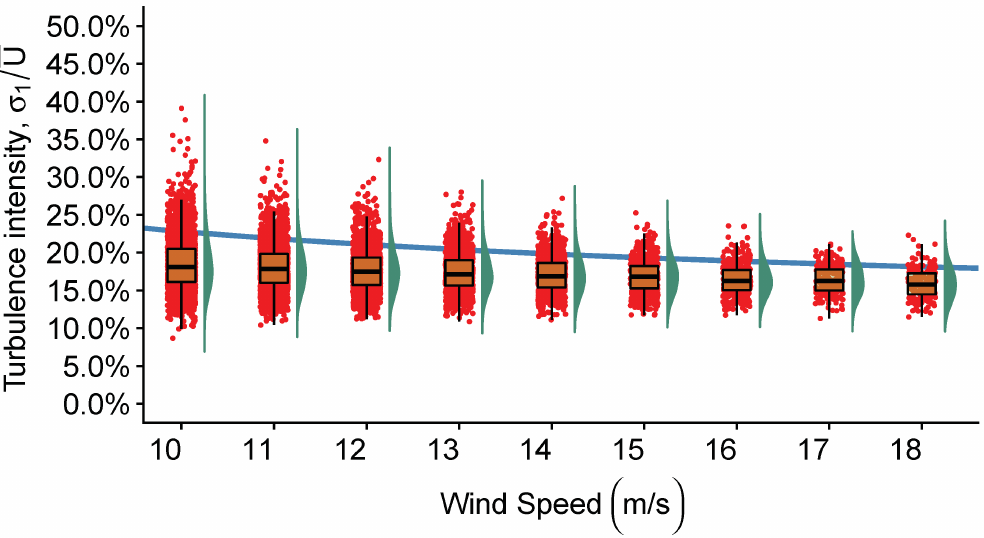
Figure 12. Box plot with NTM using I 15 = 0.18 (blue line), raw data (red dots) and the overlaid probability distribution at a height of 17.5